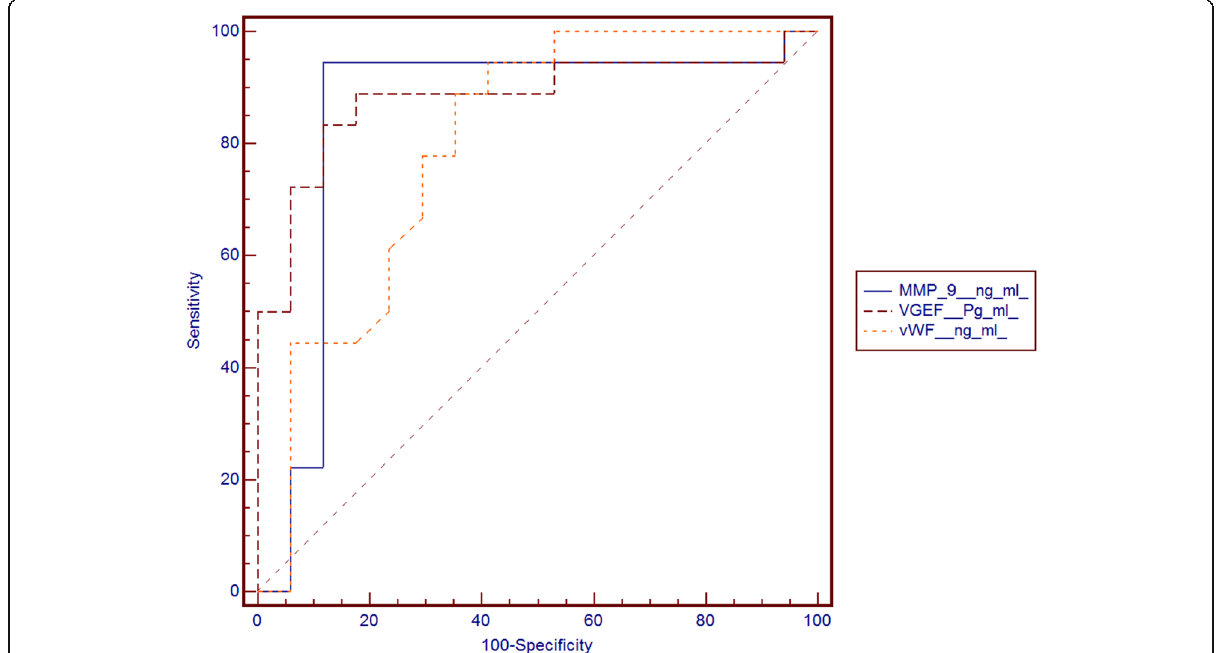
Fig. 1 ROC curve: diagnostic performance of serum biomarkers concentration in discrimination between CV and non-CV patients. Abbreviations: MMP-9 matrix metalloproteinase-9, VEGF vascular endothelial growth factor, vWF von Willebrand factor